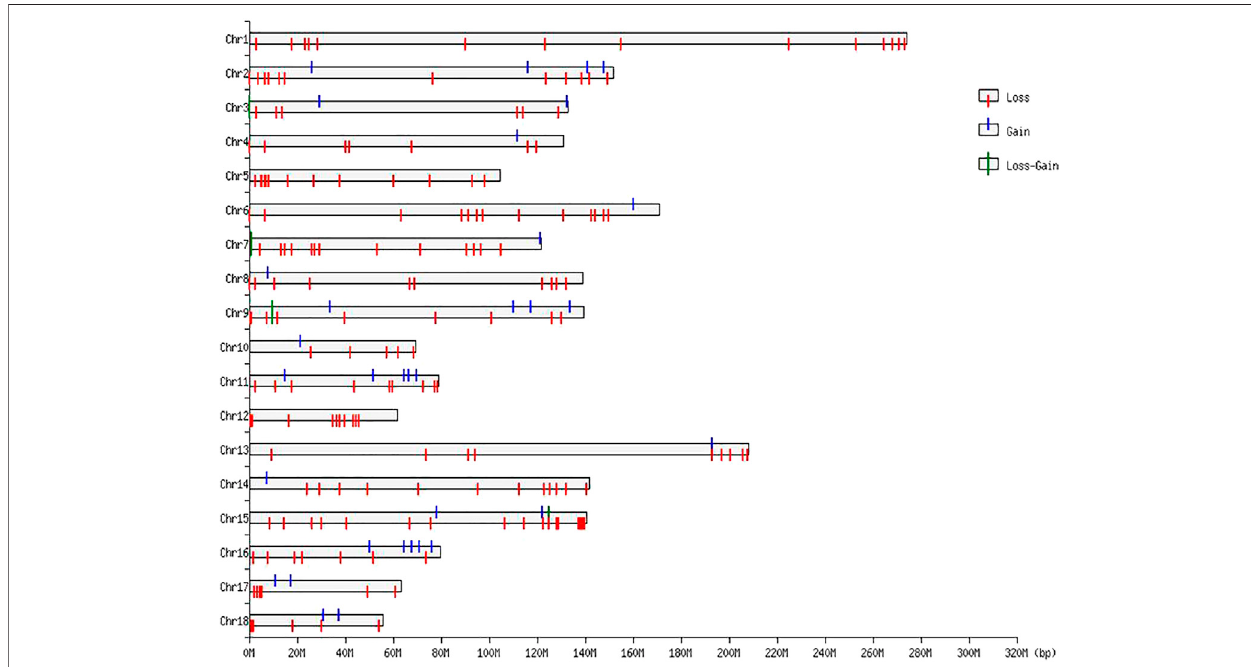
FIGURE 2 | CNVR distributions in the genome of Duroc purebred population.